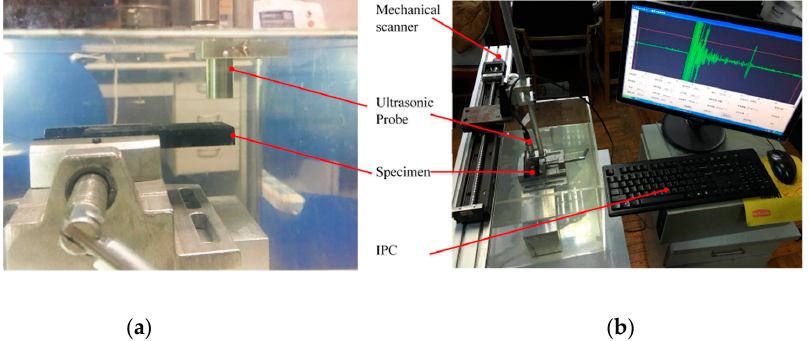
Figure 4. Ultrasonic testing system( a ) zoom of the probe onto scanned specimen ( b ) the whole testing system.